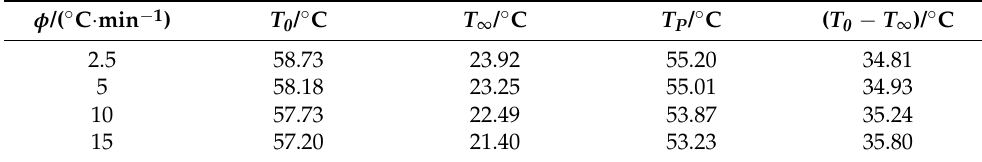
Table 10. The non-isothermal crystallization parameters in the presence of 100 ppm